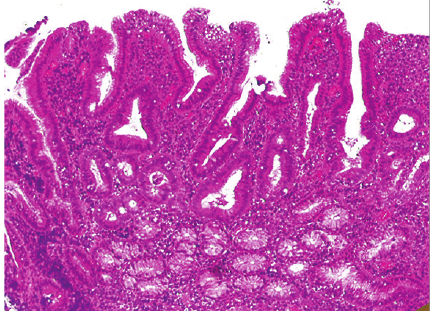
Figure 2: Histological analysis of the duodenal lesions revealed a decrease of goblet cells and severe chronic inflammation without